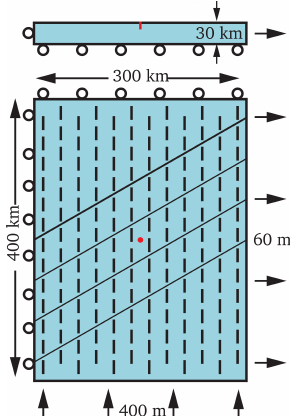
Figure 2. Reference model with the applied boundary conditions, used for all models, in map view and from the south. The model has a lateral extent of 300km × 400km and a thickness of 30km. It consists of five interconnected units, which have the same mate- rial properties. Blue visualizes the reference material (Table 2). The boundary conditions ban motion in the x direction on the western side, in the y direction on the northern side and in the z direction at the model base. A push of 400m from the south and a pull of 60m to the east is applied. The resulting S Hmax orientation (north–south) at a depth of 1000m is illustrated by the black bars. The red point (and line) indicates the location of the virtual well (Figs. 4 and 5). The four diagonal boundaries can be used as vertical faults with a chosen friction